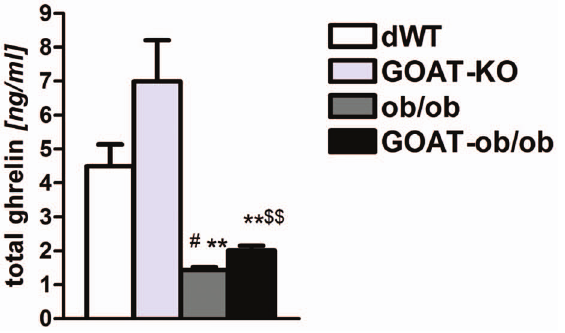
Figure 1. Total ghrelin levels in WT and GOAT-KO mice on a normal or leptin-deficient ob/ob background. GOAT-KO and GOAT-ob/ob mice with a complete lack of acyl ghrelin have increased plasma concentration of total (desacyl) ghrelin. Total ghrelin levels are lower in both ob/ob as well as GOAT-ob/ob mice, compared to lean WT controls or GOAT-KO mice on chow diet. # P , 0.05 versus dWT; ** P , 0.001 versus GOAT-KO; $$ P , 0.001 versus ob/ob; n=4–7. doi:10.1371/journal.pone.0061822.g001 PLOS ONE |